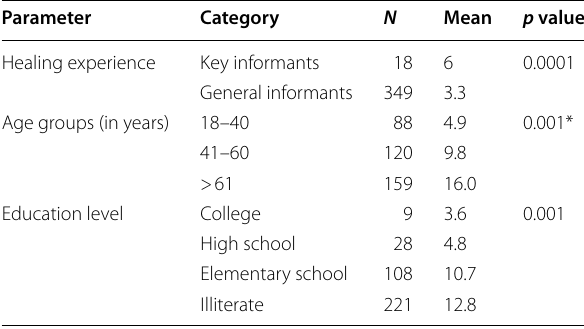
*Shows a significant difference at ( p < 0.05) between averages of the paired categories